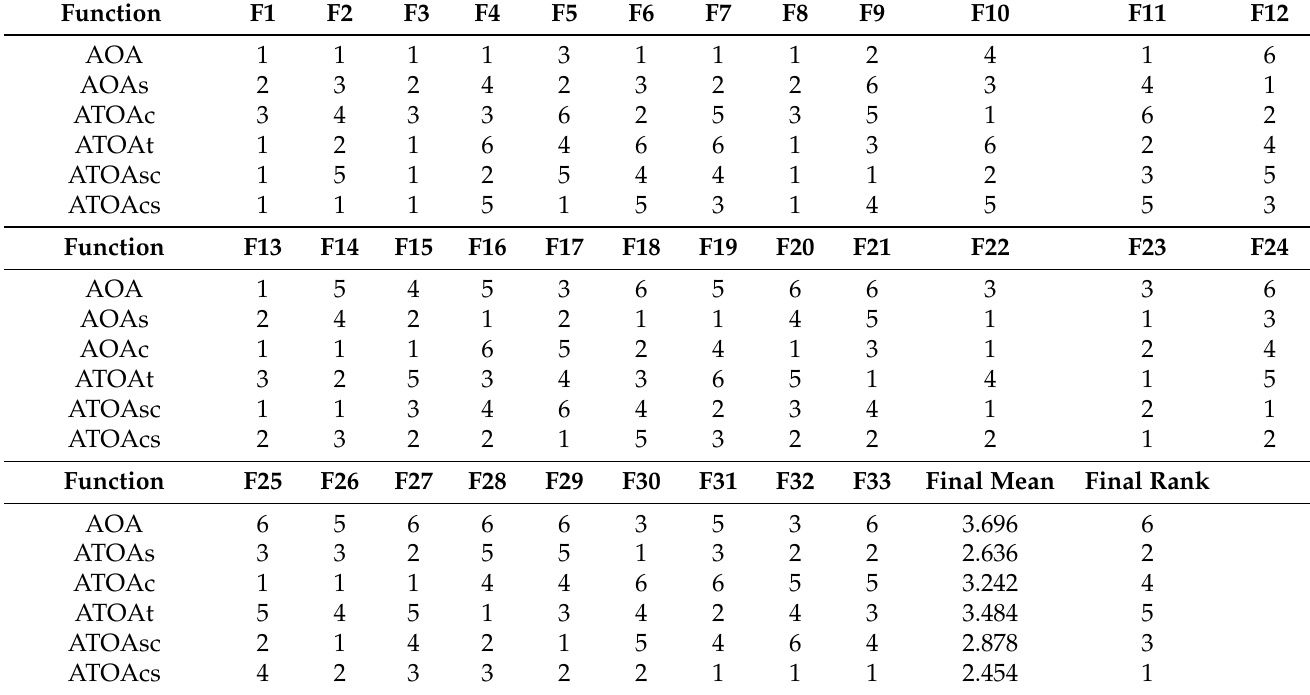
Table 4. Friedman ranking test for the optimization algorithms using the various benchmark